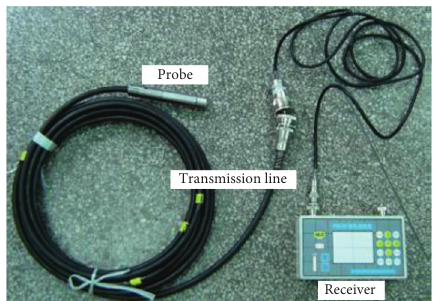
Figure 10: Detection equipment for internal fracture of the coal mass.